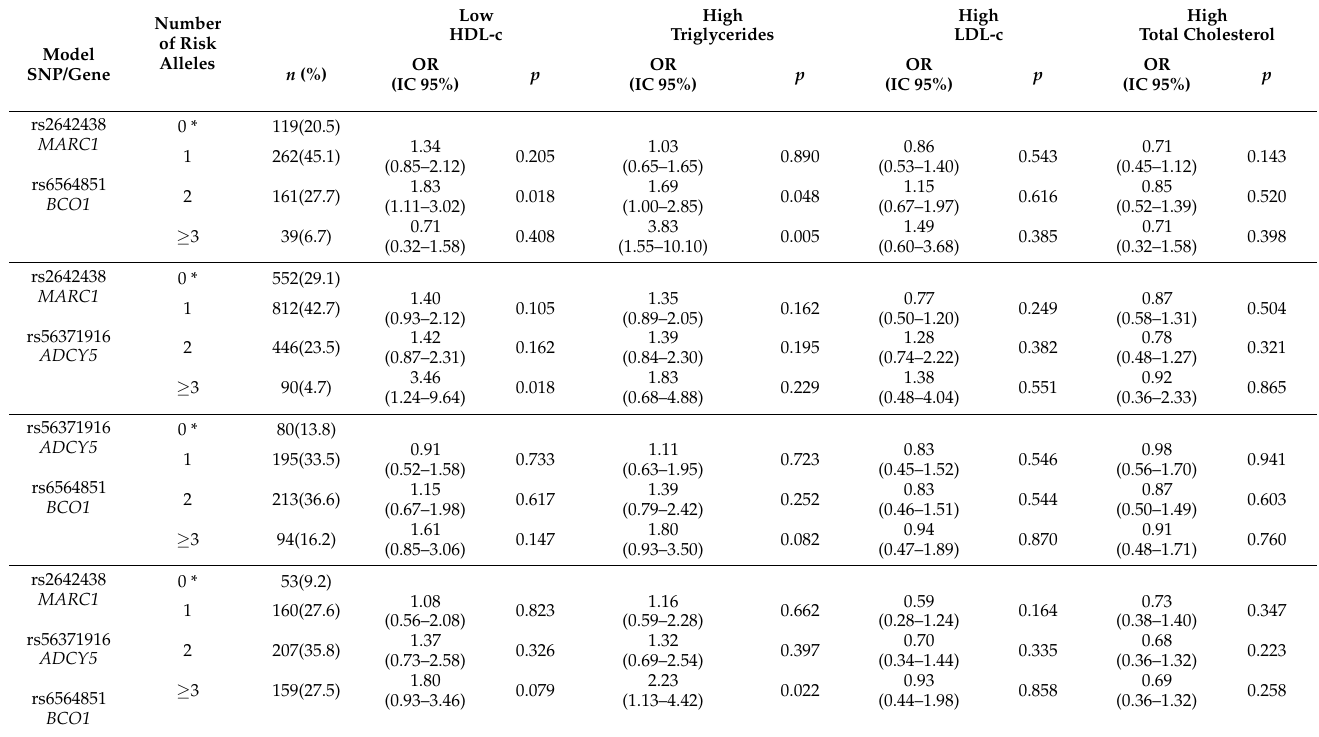
Table 3. Construction of the genetic risk score associated with lipid parameters in Mexican adult men.